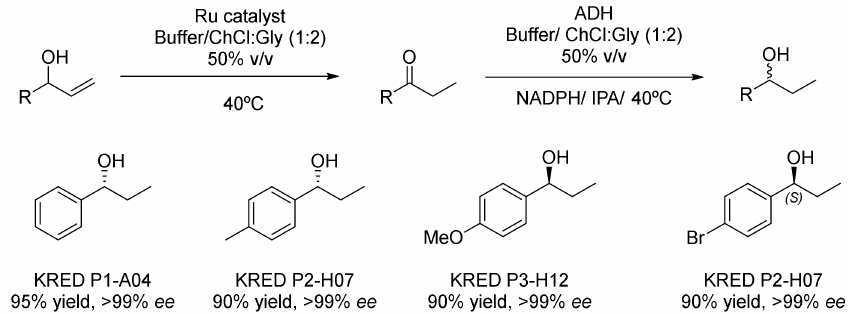
Scheme 16. General procedure for the chemoenzymatic cascade to transform allylic alcohols into chiral alcohols by combining a choline chloride-based DES bioreduction with a Ru-catalyzed isomerization.